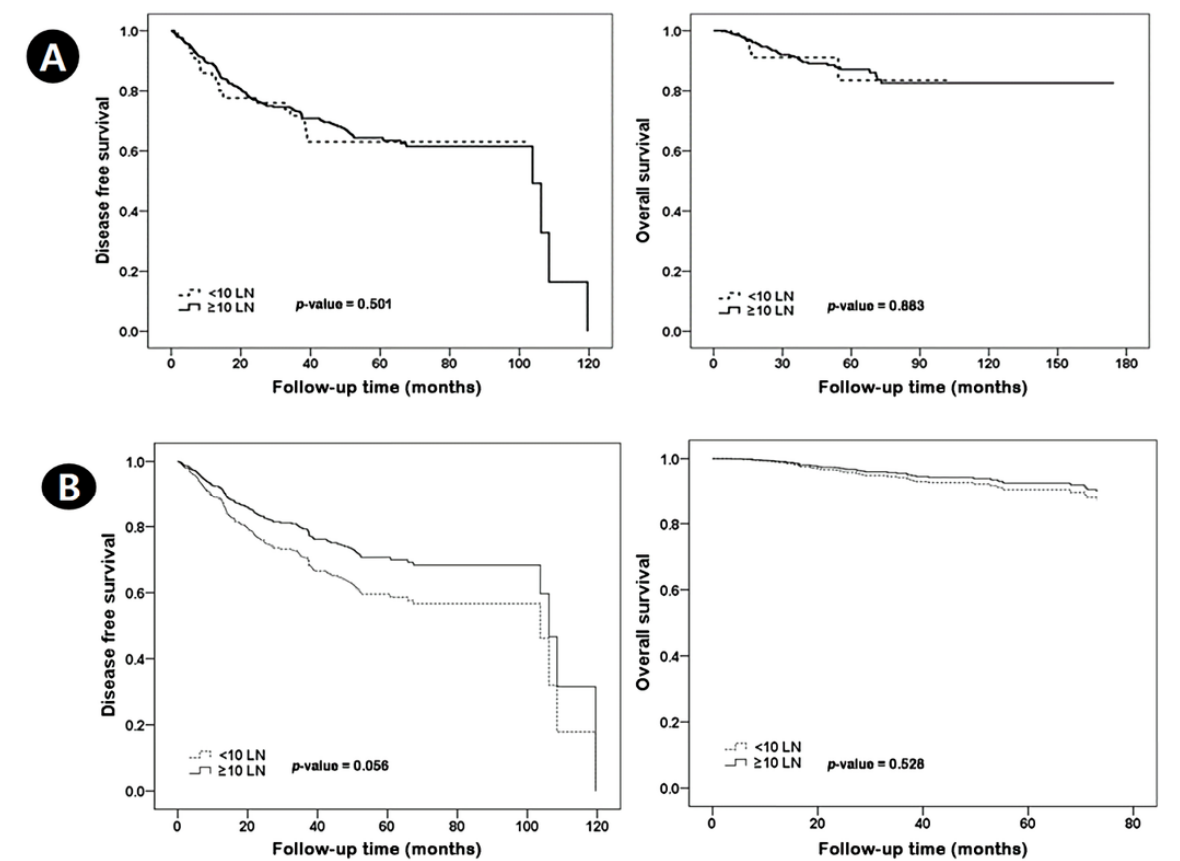
Figure 2. Kaplan–Meier survival curves for disease-free survival and overall survival according to lymph node number. Overall ( A ), compensating for ypT and ypN staging ( B ).